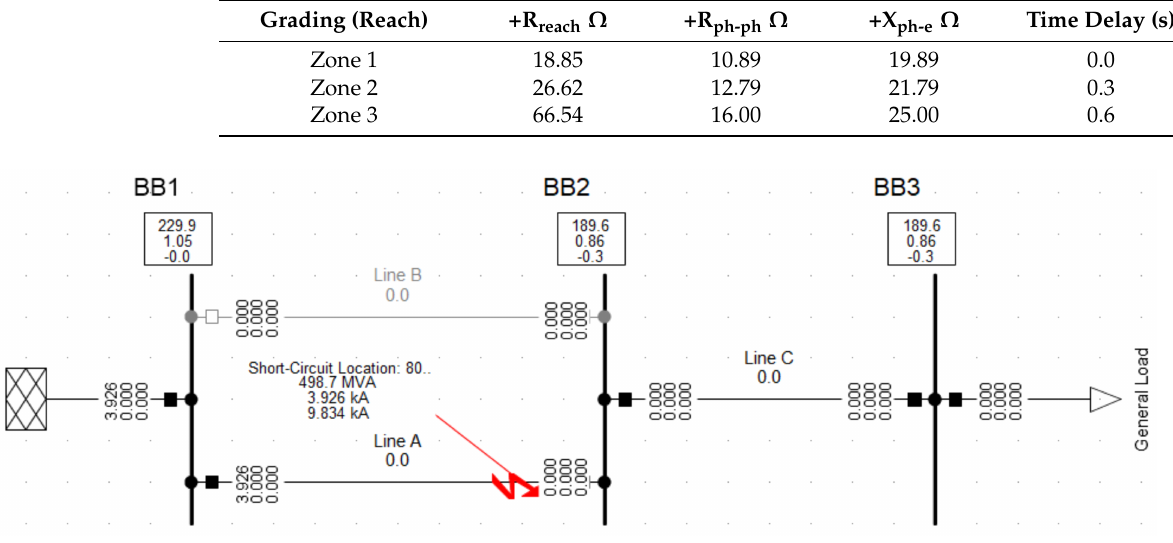
Figure 13. Single line-to-ground (SLG) fault at line A with line B